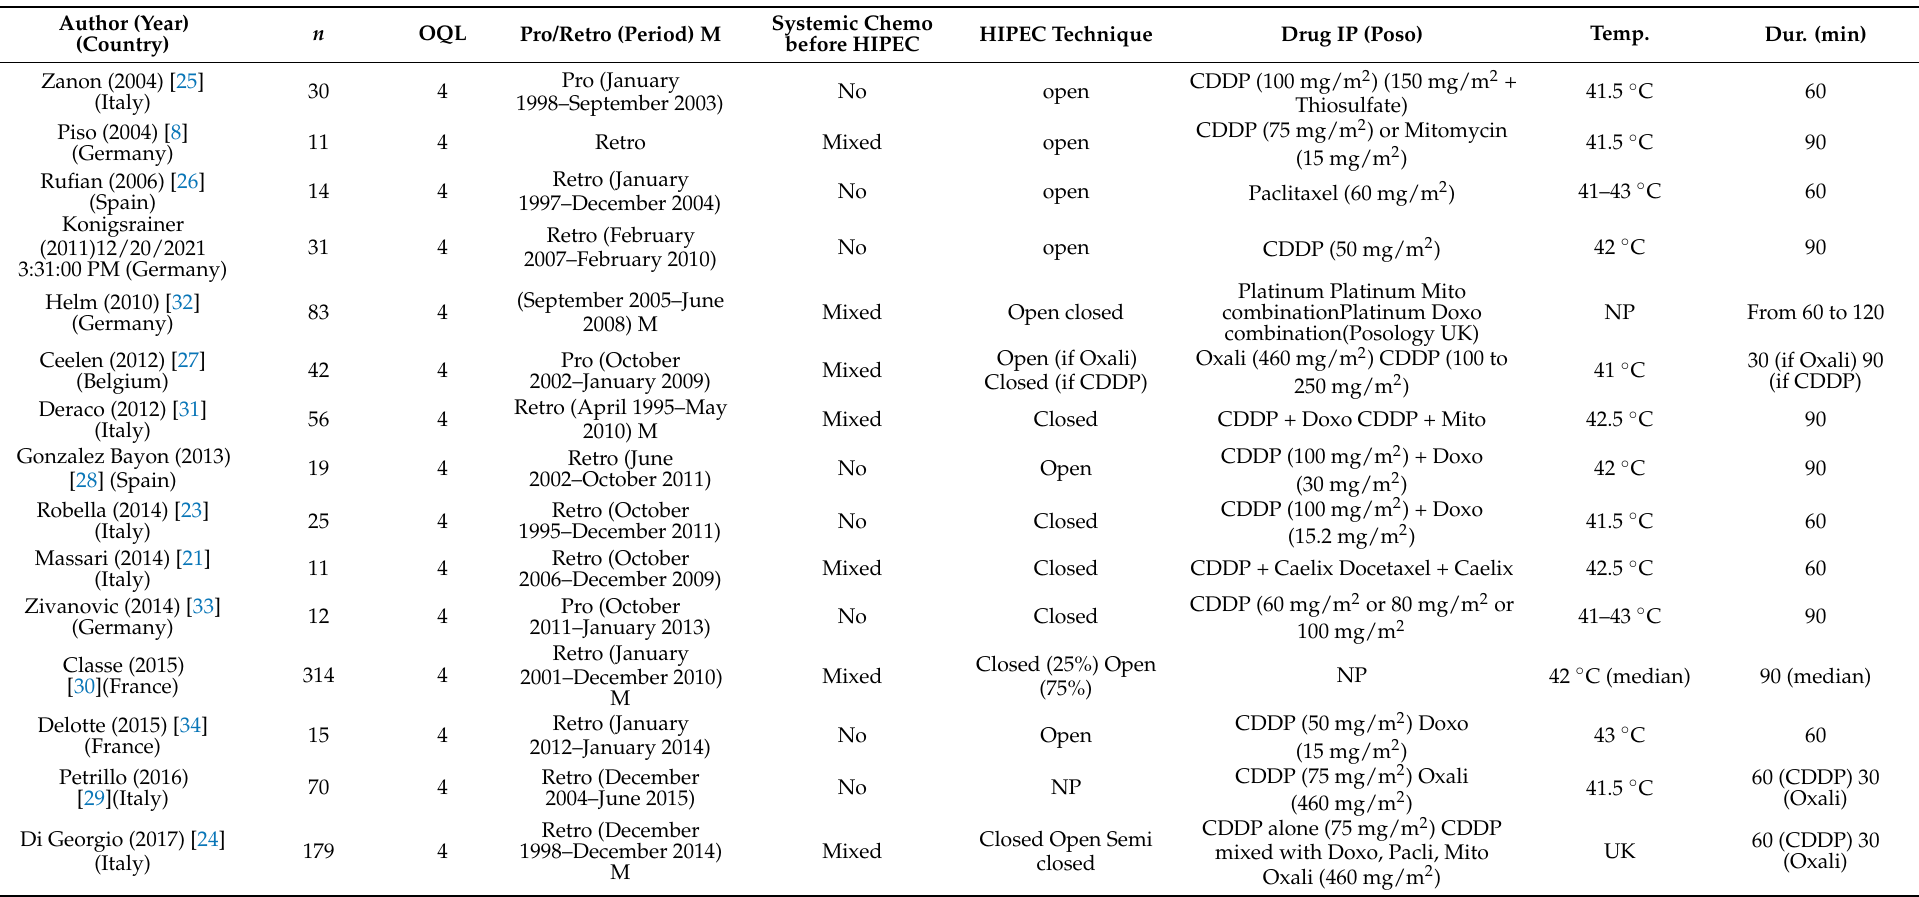
Table 1. Characteristics of series of cytoreductive surgery and hyperthermic intraperitoneal chemotherapy (HIPEC) for ovarian cancer first relapse with no control group. (PIC O : Population: ovarian cancer first relapse, Intervention: HIPEC, Comparators: HIPEC characteristics such as intraperitoneal drug, posology, temperature,